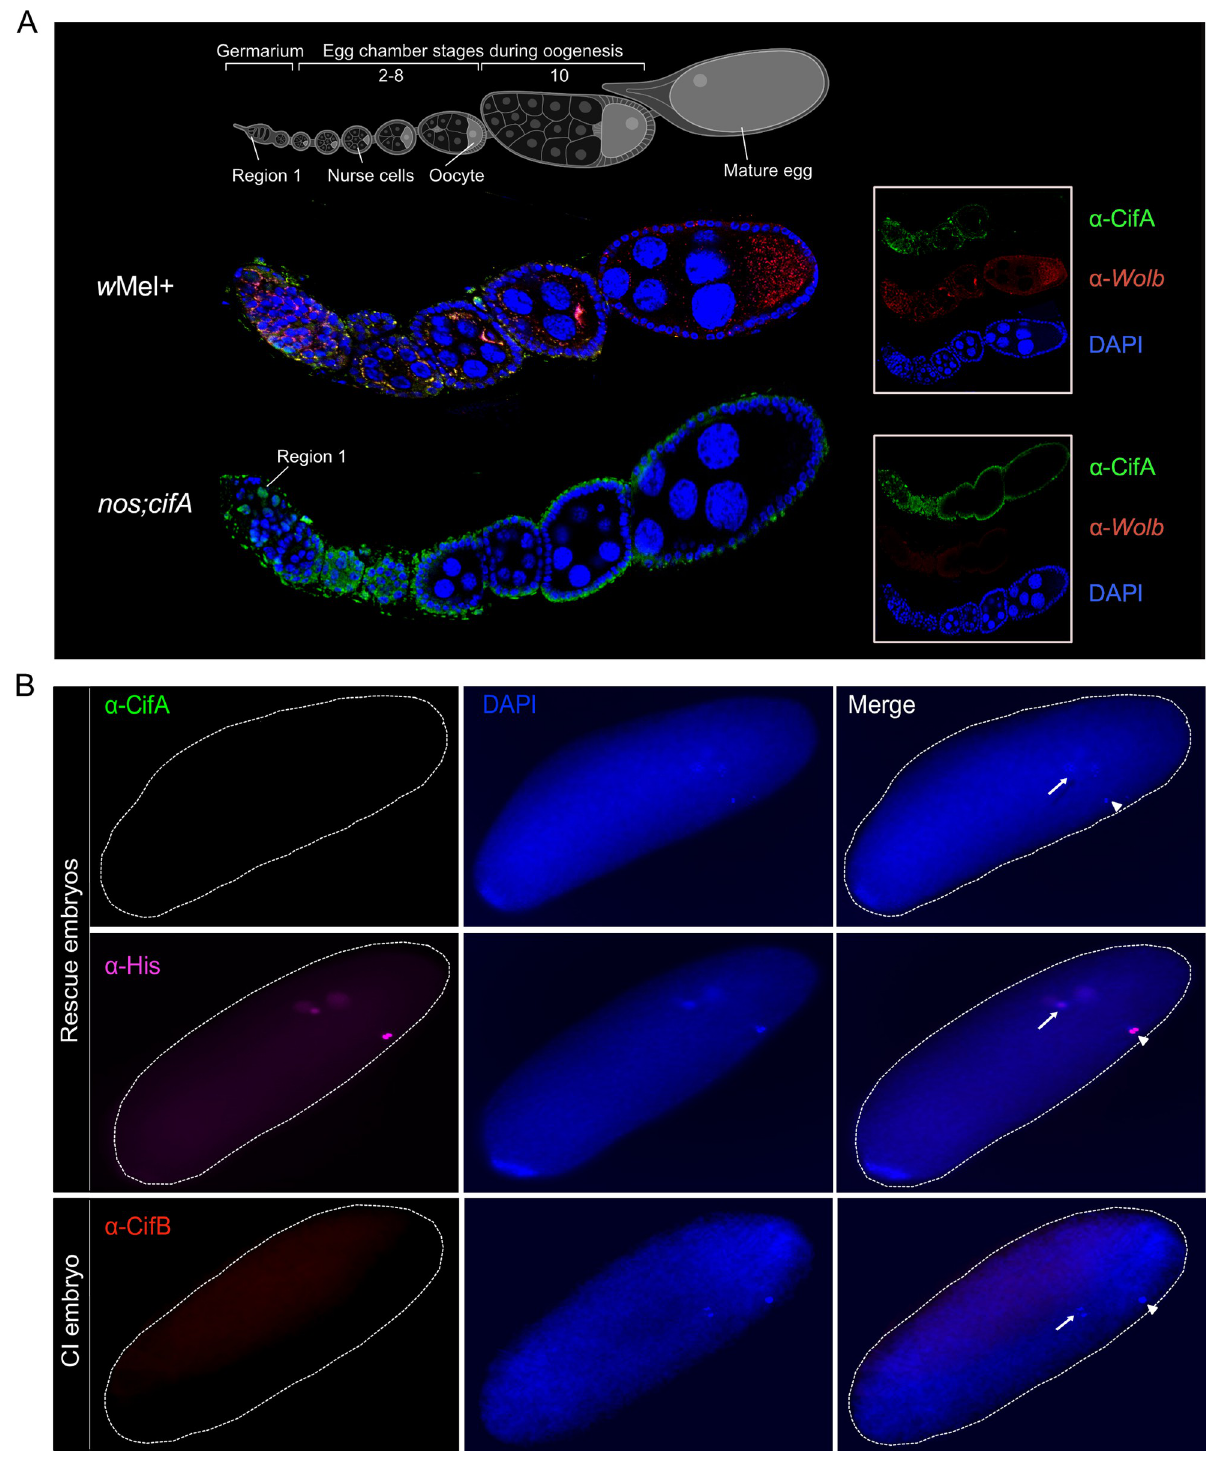
Fig 6. CifA is present in early oogenesis and absent in late-stage egg chambers. Both CifA and CifB are absent in CI and rescue embryos. (A) Schematic representation of Drosophila melanogaster ovariole at the top illustrates the stages of oogenesis from left to right. Image was created with BioRender.com. Immunostaining assay indicates localization of CifA (green) to the cyst DNA (blue labeled with DAPI) in region 1 of the germarium of Wolbachia -uninfected transgenic cifA line. In w Mel+ line, CifA colocalizes with Wolbachia (red) in the germarium, nurse cells and oocyte cytoplasm along 2–8 stages of egg chambers. CifA is absent in stage 10 egg chamber, whereas Wolbachia signals persist. In the transgenic cifA line,